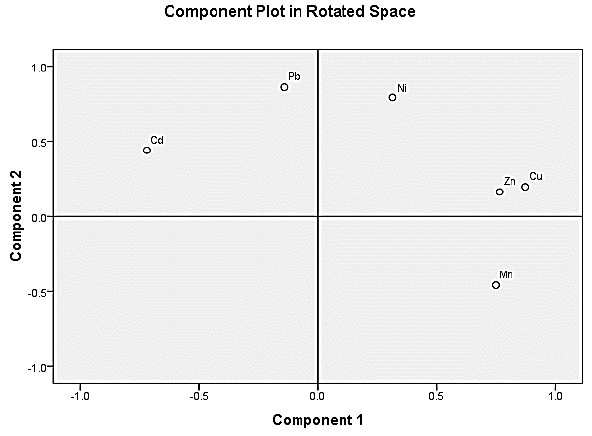
Figure 3. Principal Component Analysis (PCA) of studied metals of the Chalan beel area. Table 7. Pearson correlation among heavy metals in Chalan beel area.